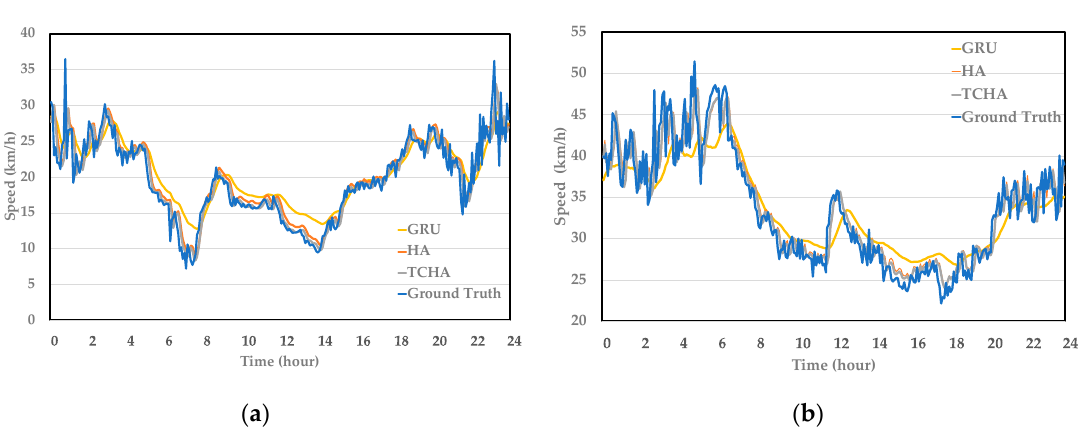
10 of 13 Table 2. Performance of difference prediction horizons (Tonghui Road). Algorithm